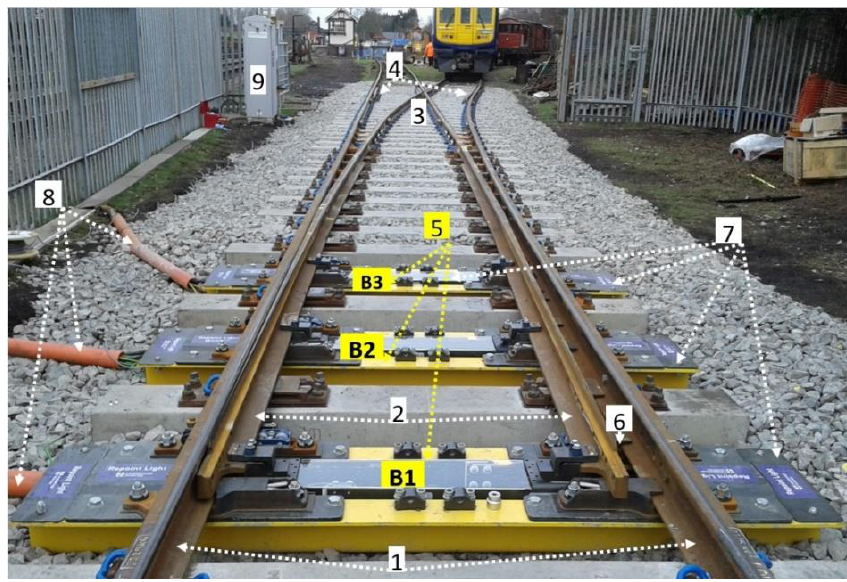
Figure 2. REPOINT-Light track switch at great central railway Quorn and Woodhouse station, UK: 1. Stock rails, 2. Movable switch rails, 3. Common crossing, 4. Check rails, 5. Actuator bearer with locking elements, 6. Rail detection sensors, 7. Bearer coves, 8. Connections between the control unit and bearer elements, 9. Control unit.